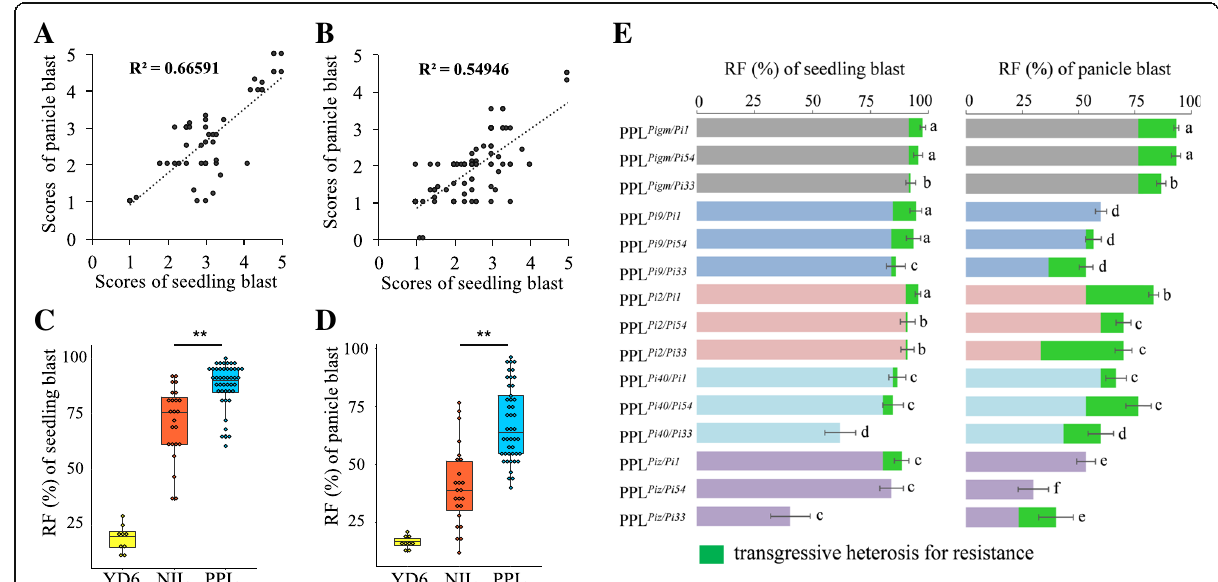
Fig. 2 Resistance performances of PPLs for seedling and panicle blast resistance. a Correlation analysis of seedling blast resistance with panicle blast resistance of NILs, b Correlation analysis of seedling blast resistance with panicle blast resistance of PPLs, c Comprehensive comparative analysis on seedling blast RF of PPLs, NILs and the recurrent parent, d Comprehensive comparative analysis on panicle blast RF of PPLs, NILs and the recurrent parent, e transgressive heterosis for seedling blast and panicle blast resistance produced by PPLs after different broad-spectrum R